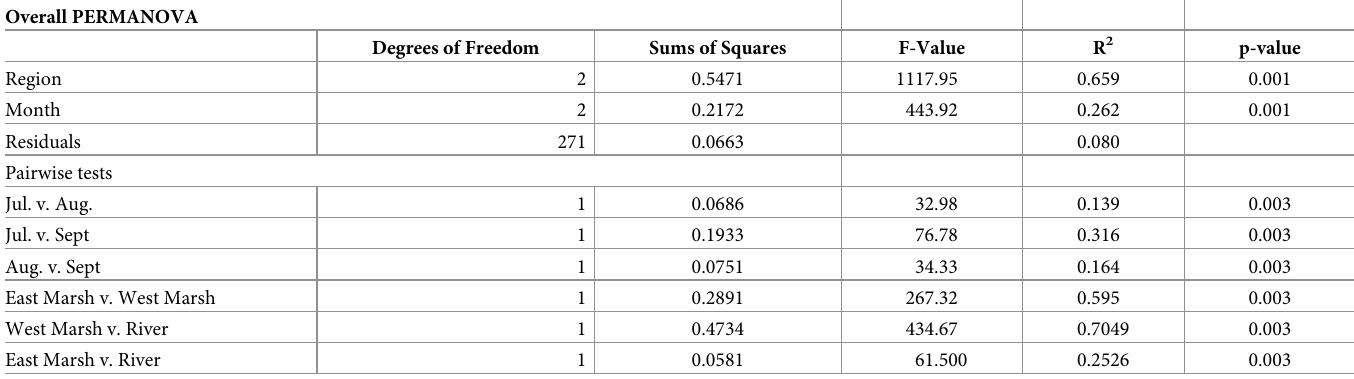
Table 3. Results of a Permutational Multivariate Analysis of Variance (PERMANOVA) on the salinity, temperature, chlorophyll, and turbidity for the River, East Marsh and West Marsh regions between months (July, August, September). (corresponding to groups in NMDS plot). Overall PERMANOVA Degrees of Freedom Sums of Squares F-Value R 2 p-value Region 2 0.5471 1117.95 0.659 0.001